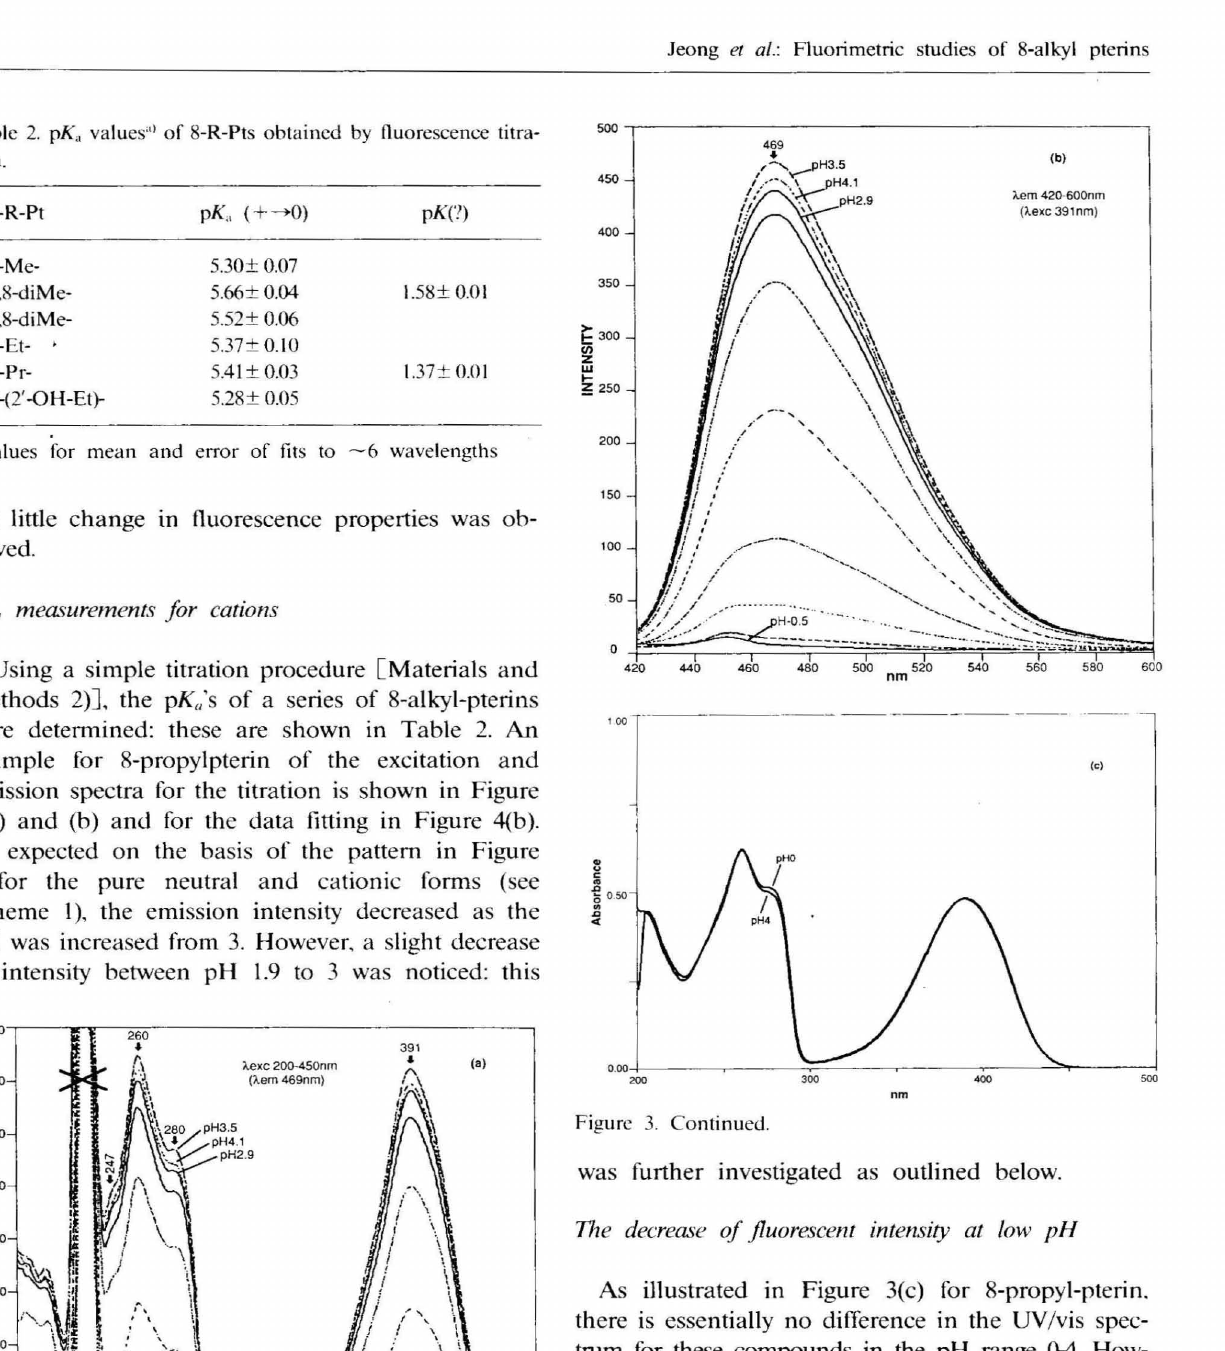
Table 2. pK" values") of 8-R-Pts obtained by fluorescence titra tion.